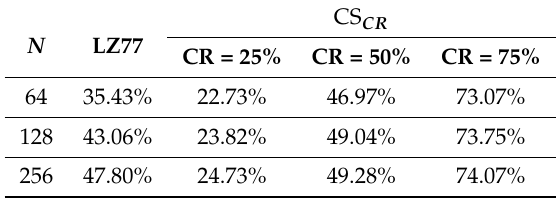
Table 5. Total energy consumption savings compared to raw sensor value